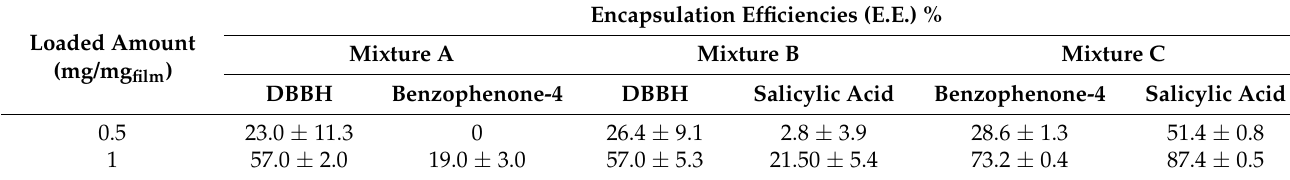
Table 1. Encapsulation efficiency (E.E.) values for different mixtures. Encapsulation Efficiencies (E.E.) Loaded Amount (mg/mg film )